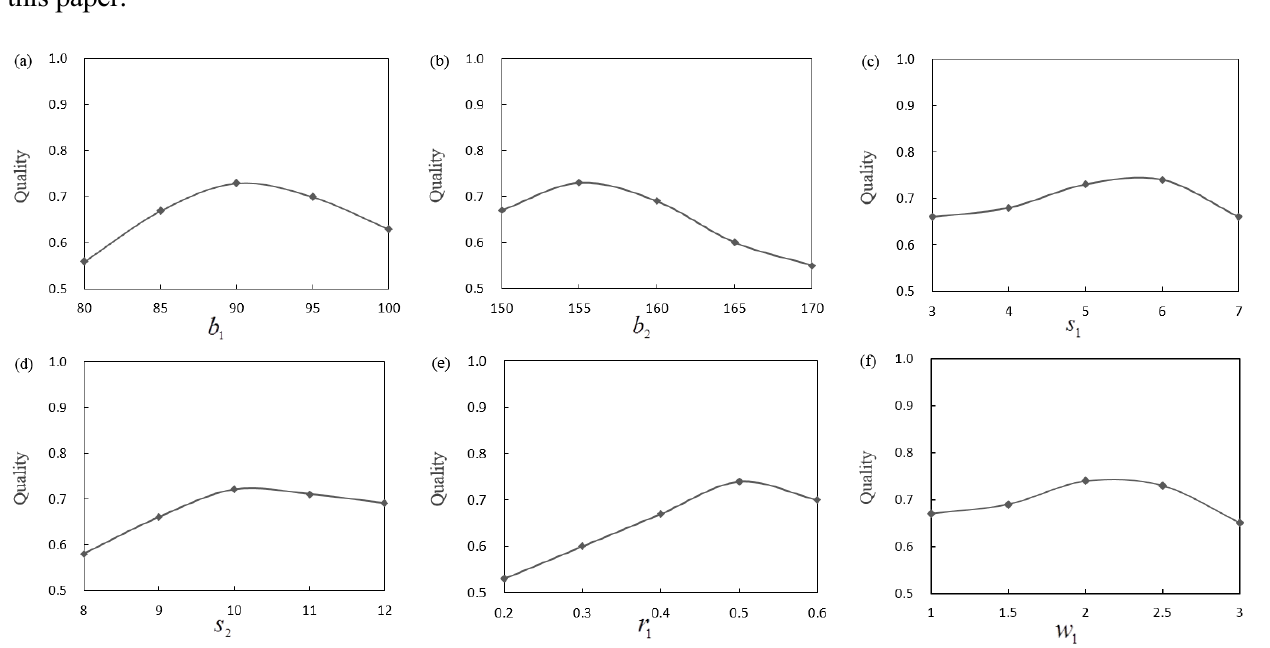
b ; ( b ) the 1 s ; ( d ) the standard deviation 1 r ; ( f ) the length-to-width ratio threshold w 1 1